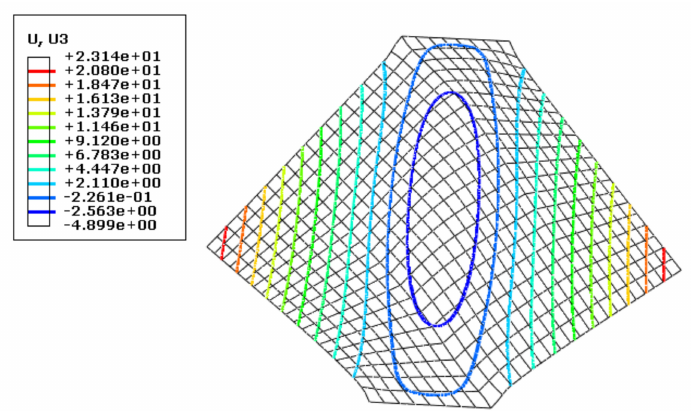
Figure 5. Simulation results for wrinkling of a sheet disturbed by a concentrated force.